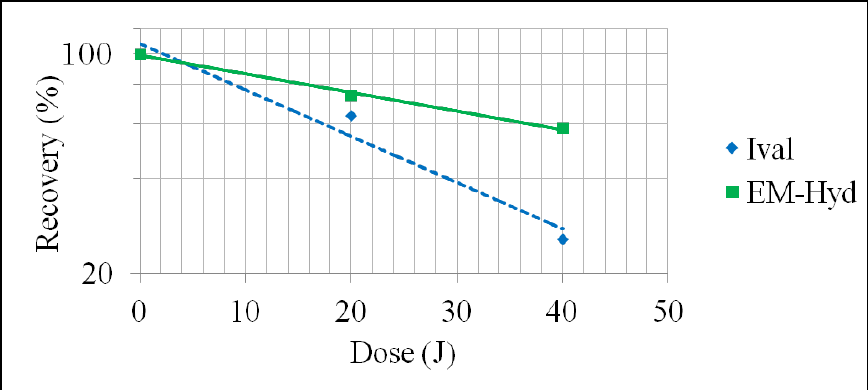
Figure 3. Stability of Ival and EM-Hyd against γ-ray